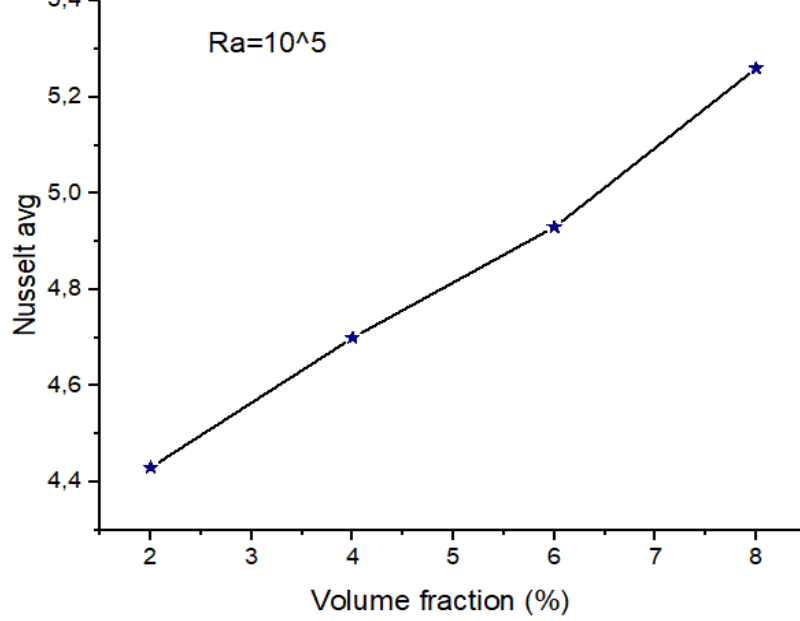
Figure 4. Average Nu for Ra = 10 5 , Ha = 0, and w = 0.